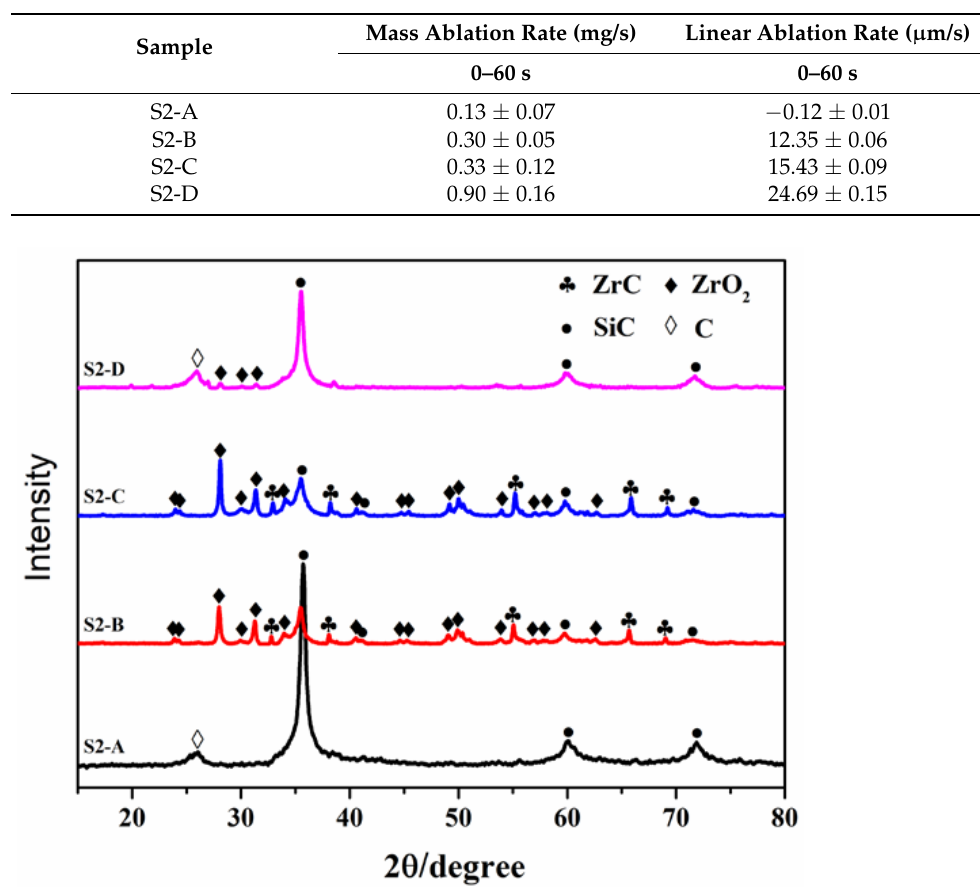
Figure 6. XRD patterns of the S2 coatings after 60 s ablation.